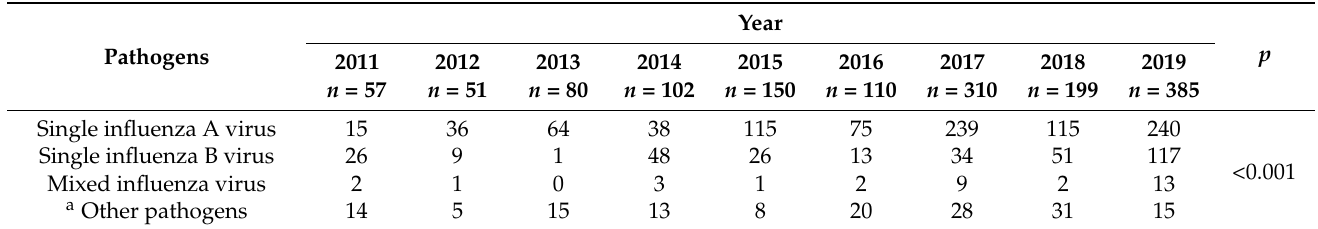
Table 2. The risk factors of influenza virus and other pathogens from analyzed URTI cluster data from 2011 to 2019, Taiwan.